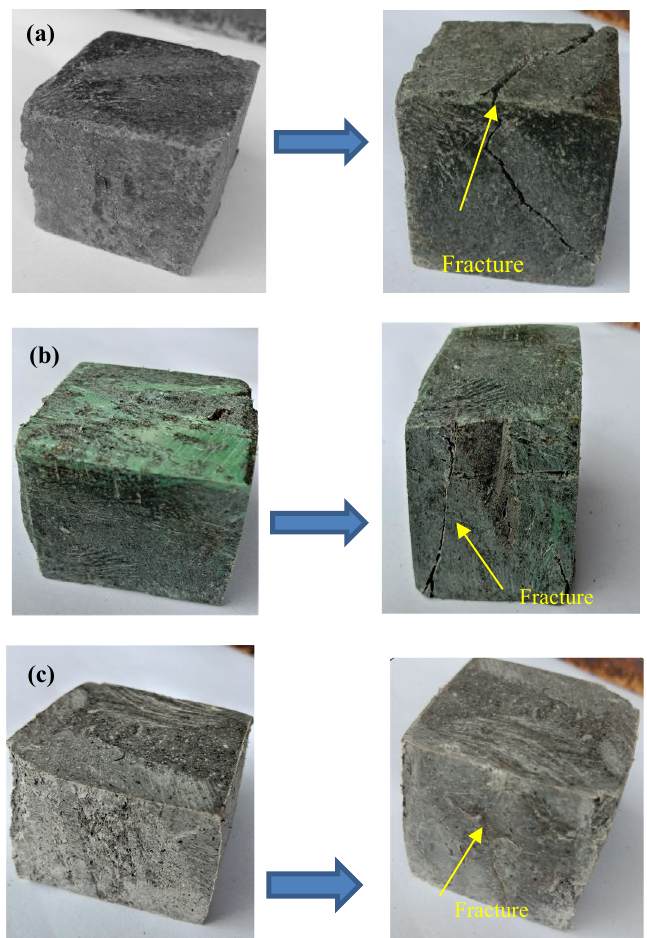
Figure 12. Image of specimen before and after compression test ( a ) S1, ( b ) S2, ( c ) S3.